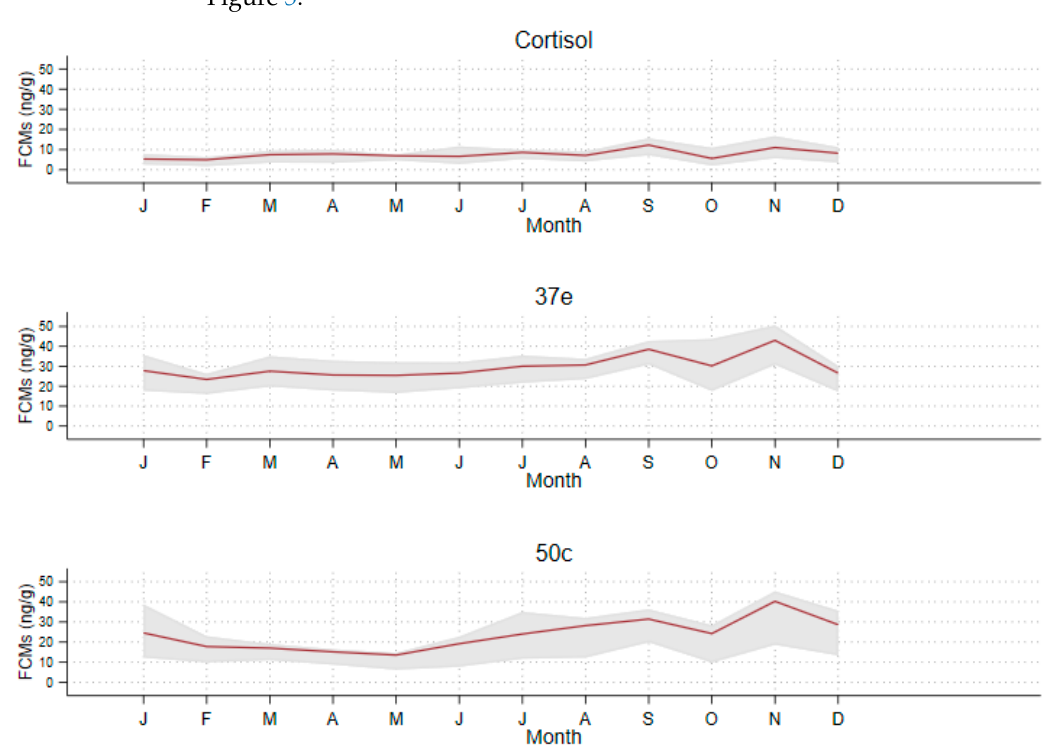
Figure 5. Monthly mean (red line) and 95% percentile (shaded area) FCM (faecal cortisol metabolite) values (ng/g) measured with the cortisol, 37e (5 α -pregnane-3 β ,11 β ,21-triol-20-one) and 50c (tetrahydrocorticosterone) EIAs (enzyme immunoassays) (defecations: n = 351).